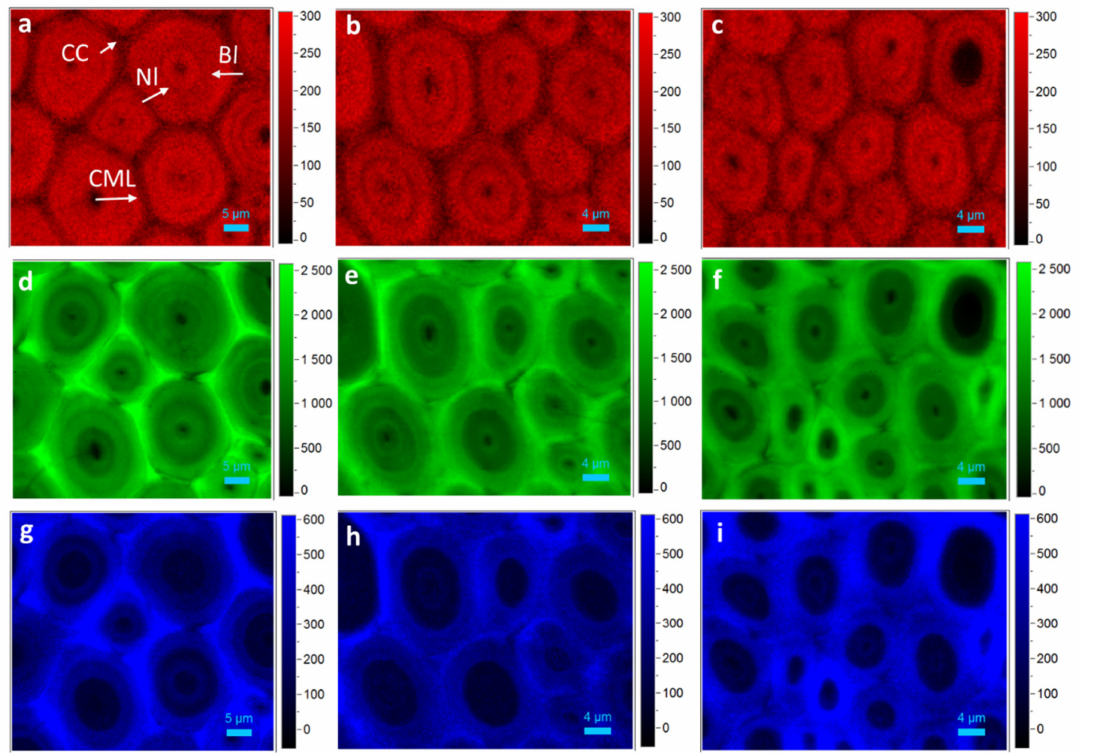
Figure 3. Raman images showing the distribution of fiber wall components from Bg ( a,d,g ), Bt ( b,e,h ) and By ( c,f,i ). ( a – c ) Carbohydrates, 2800–2918 cm − 1 ; ( d – f ) Lignin, 1540–1660 cm − 1 ; ( g – i ) HCA, 1120–1200 cm − 1